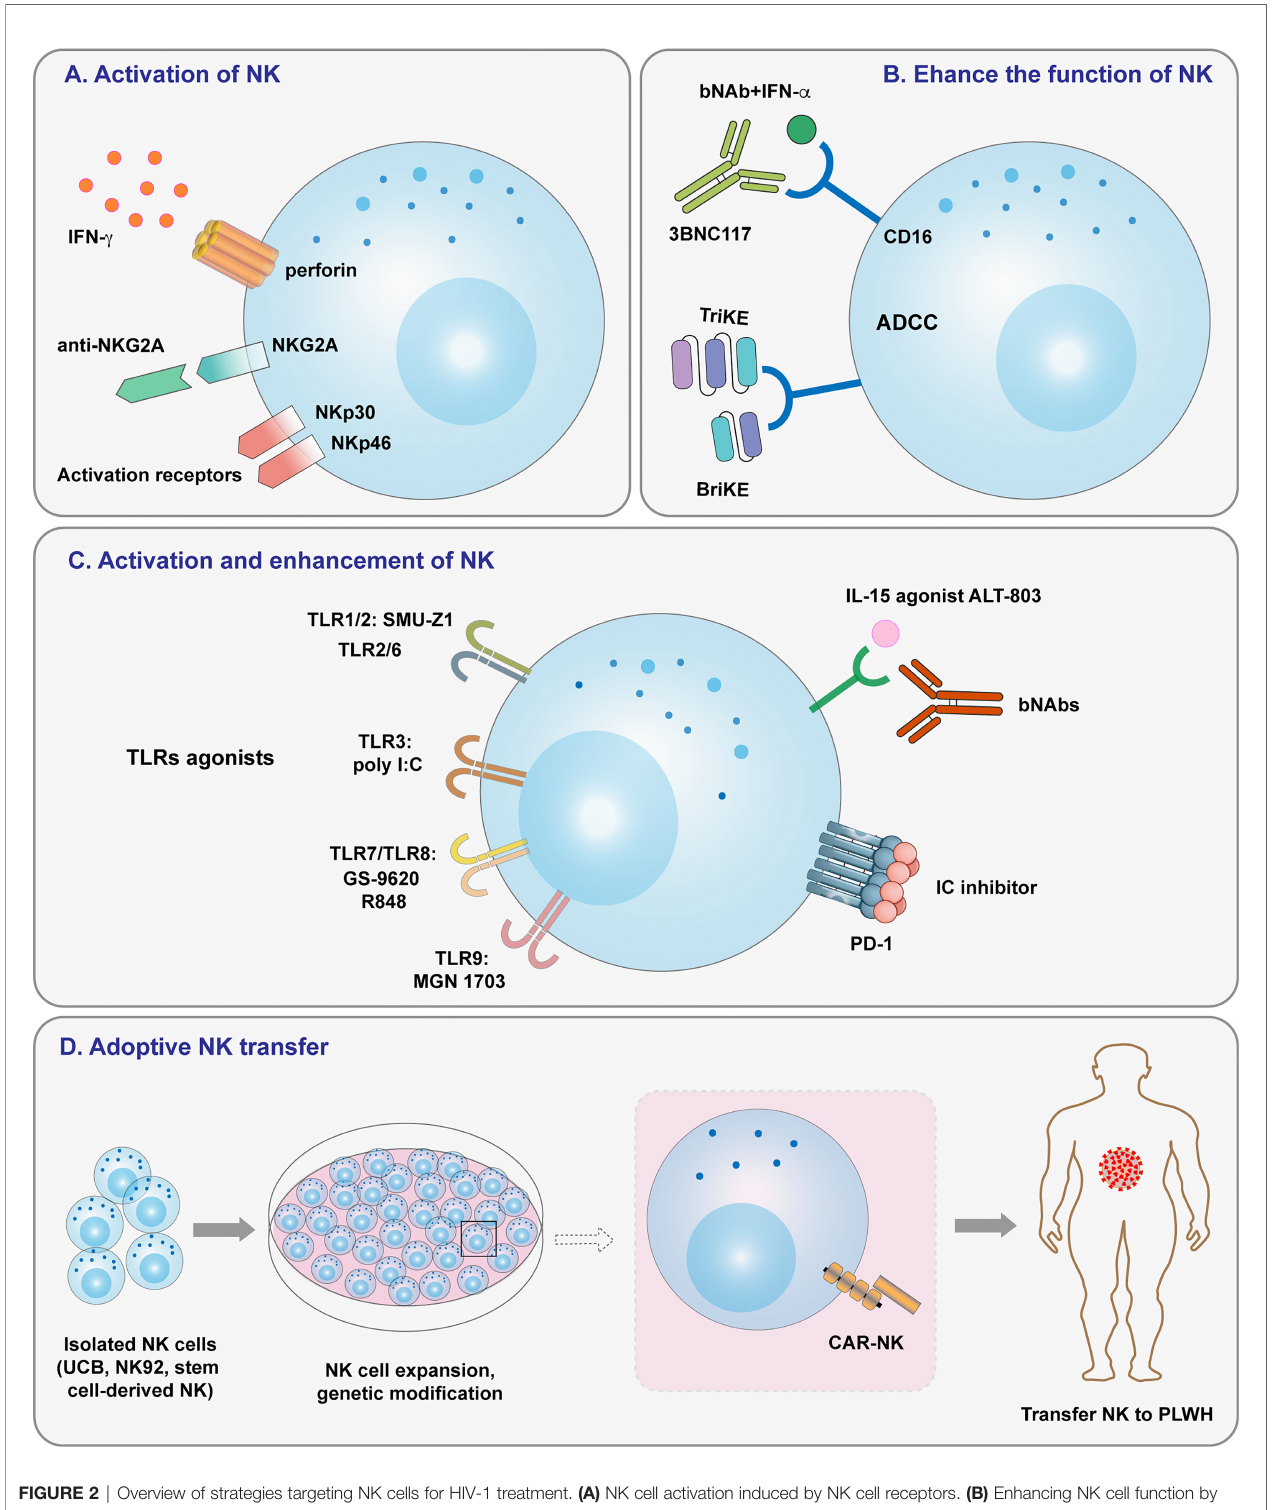
FIGURE 2 | Overview of strategies targeting NK cells for HIV-1 treatment. (A) NK cell activation induced by NK cell receptors. (B) Enhancing NK cell function by ADCC and speci fi c antibodies. (C) Activating and enhancing NK cell activity by TLR agonists, IL-15 agonists, and immune checkpoint inhibitors. (D) Adoptive cell transfer, including that of haploidentical NK cells, allogeneic NK cells, and CAR-NK